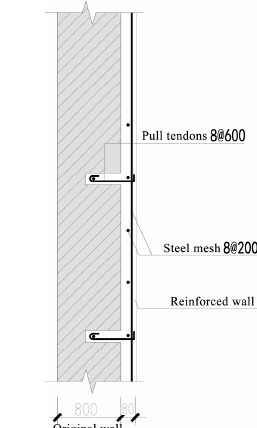
Figure 14. Diagram of reinforcement of foundation ( left ) and wall ( right ). Picture by X.X.